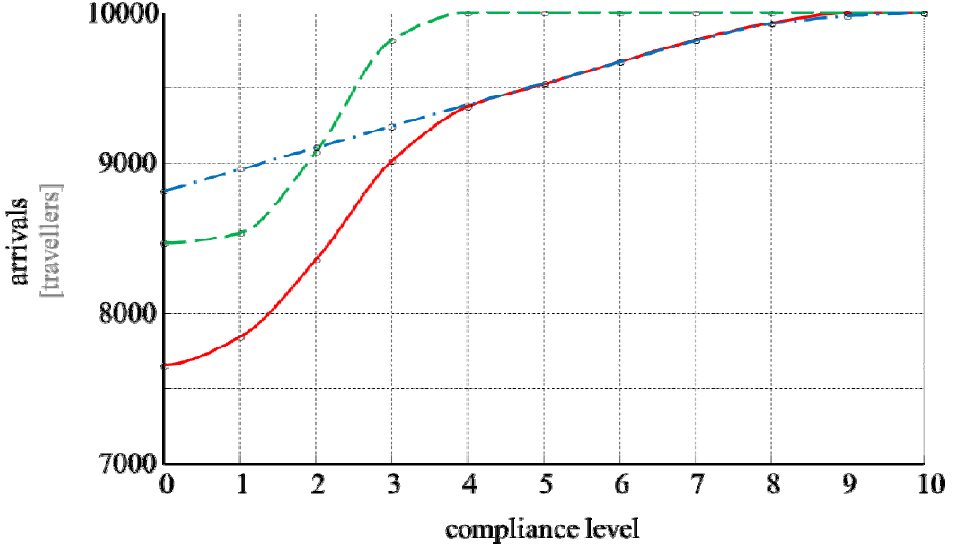
Figure 6. Total number of arrivals as a function of traveller compliance level: red solid line, varying departure time (DP) and destination and route (D&R) compliance level; green dashed line, varying D&R compliance level (with full compliance to DP); blue dash-dotted line, varying DP compliance level (with full compliance to